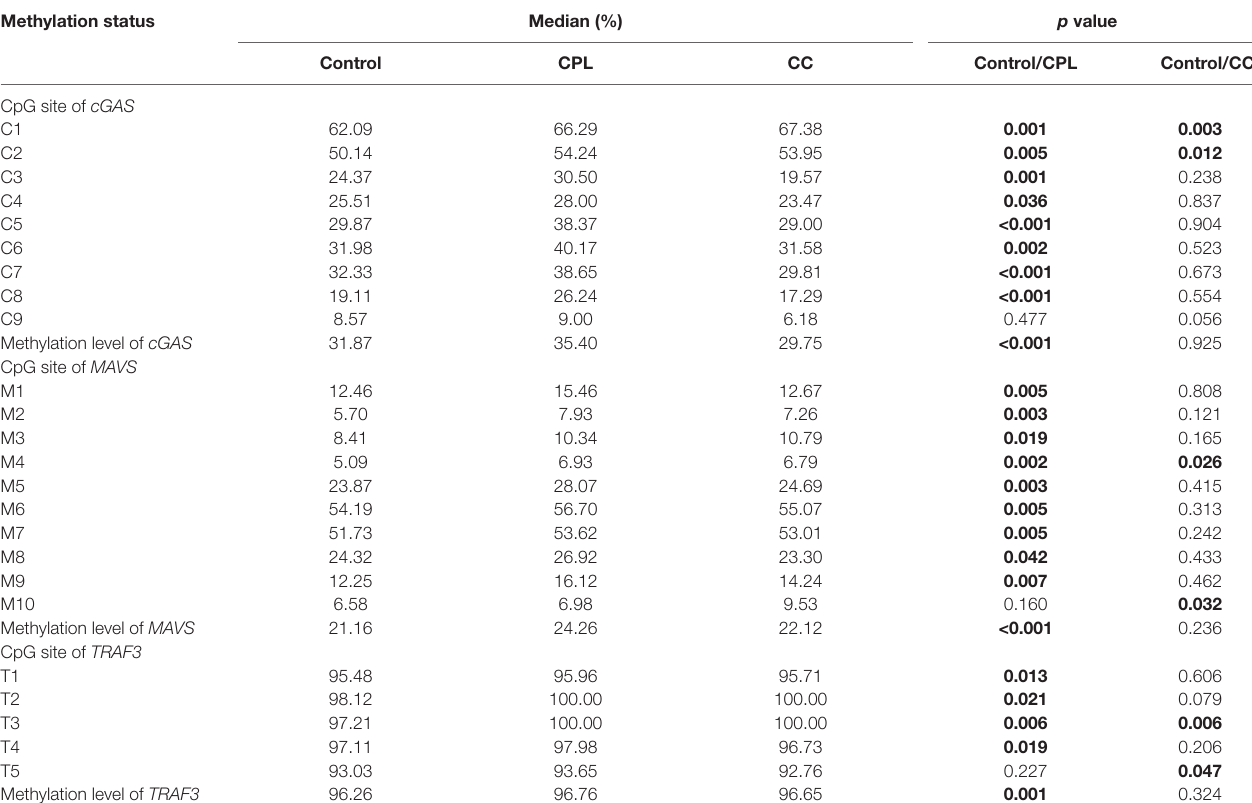
TABLe 2 | Promoter methylation status of cyclic GMP-AMP synthase ( cGAS) /mitochondrial antiviral-signaling ( MAVS) /tumor necrosis factor receptor-associated factor 3 ( TRAF3) in control, cervical precancerous lesion (CPL), and cervical cancer (CC).